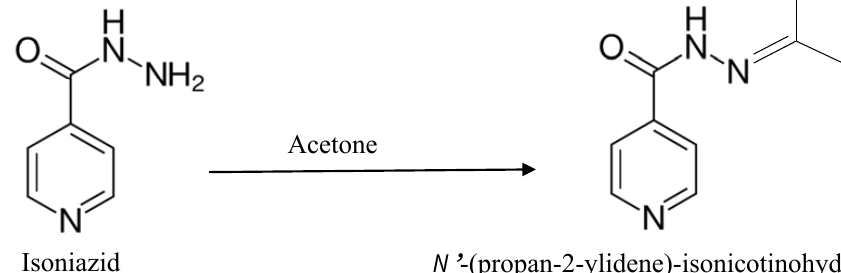
Figure 2. Reaction scheme for the synthesis of N ′ -(propan-2-ylidene)-isonicotinohydrazide.